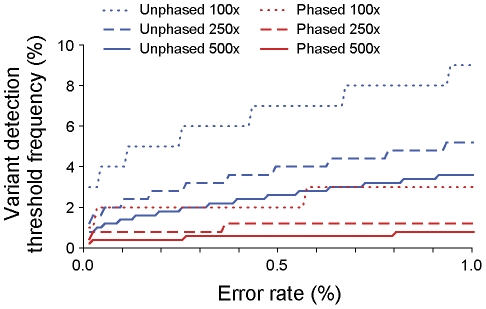
Phase increased sensitivity to detect variants.Phase increased sensitivity to detect variants, as seen over a range of error rates at coverages of 100-fold, 250-fold, and 500-fold. The phased variant detection threshold frequency (VDTF) is the lowest frequency of reads with variants at two specific loci that V-Phaser can distinguish from error among reads that span both loci. The unphased VDTF is the lowest frequency of one variant that V-Phaser can distinguish from error among reads that cover that locus. 100-fold phased sequence coverage achieves comparable detection thresholds as 500-fold unphased. We use Equation 7 to calculate the phased and unphased VDTFs. (See the Materials and Methods section for Equation 7 and its derivation.)